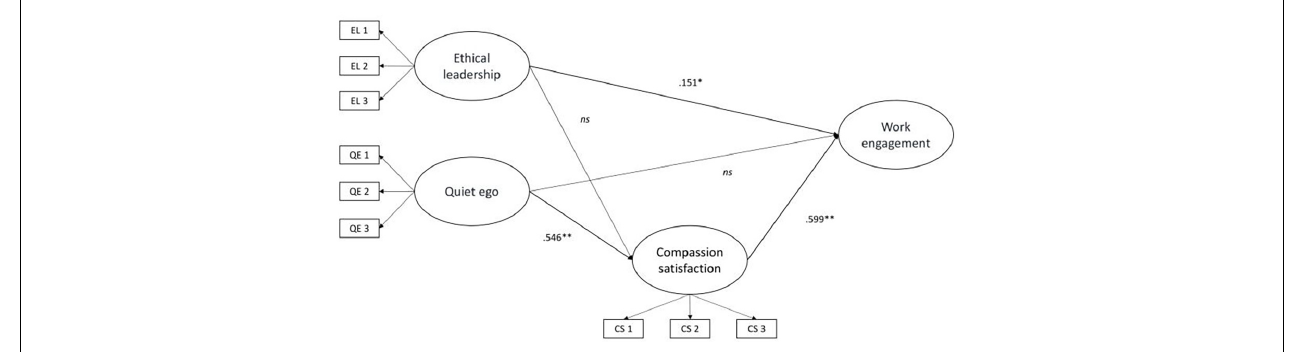
FIGURE 2 | Results of the structural equation model. Standardized direct effects were reported. ∗ p < 0.05, ∗∗ p < 0.01. EL, Ethical Leadership; QE, Quiet Ego; CS, Compassion